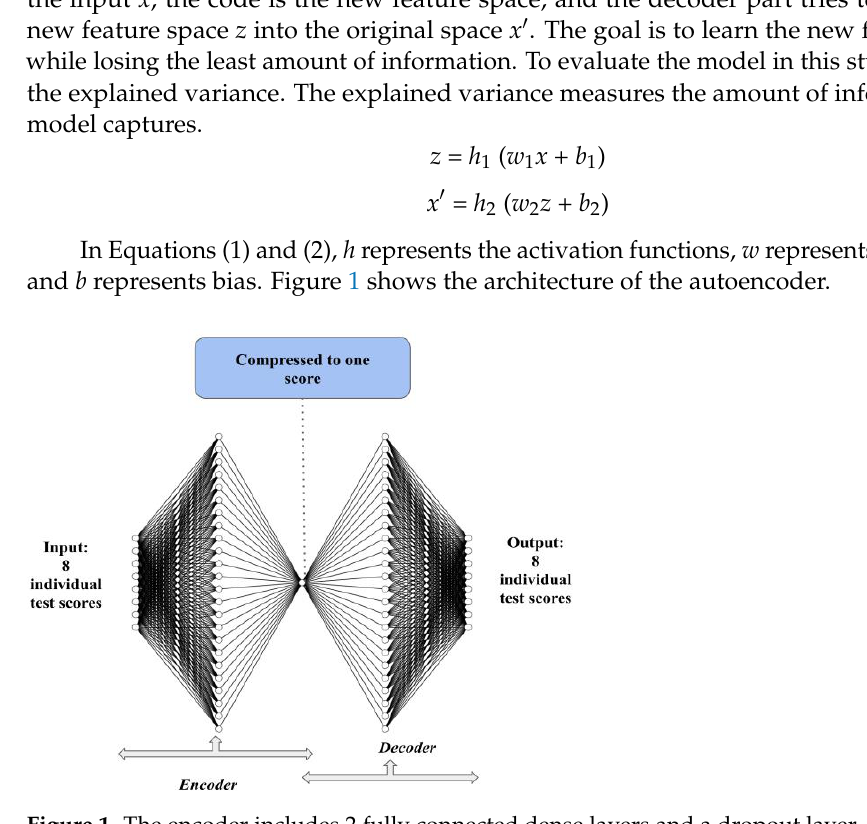
Figure 1. The encoder includes 2 fully connected dense layers and a dropout layer. The first layer is the input layer of 8 test scores. The single central neuron is the compressed score. The decoder contains 2 fully connected dense layers and a dropout layer. The output layer has 8 neurons that retrace the